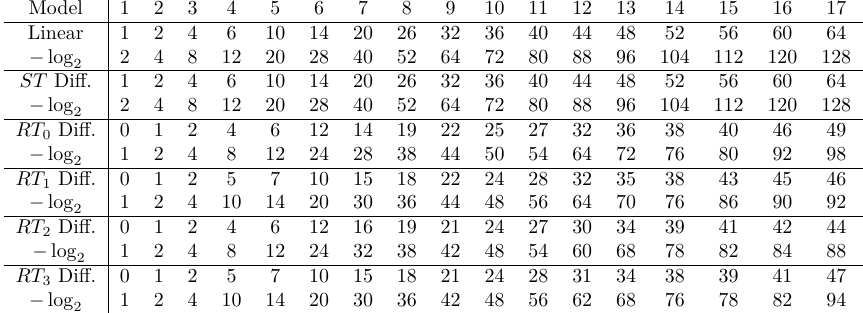
Table 5: Optimum differential/linear trails for reduced CRAFT in different model, where for each model, the upper row determines the minimum number of active S-boxes and the lower row shows the − log P , and also P denotes the probability of the best-found trail. 2